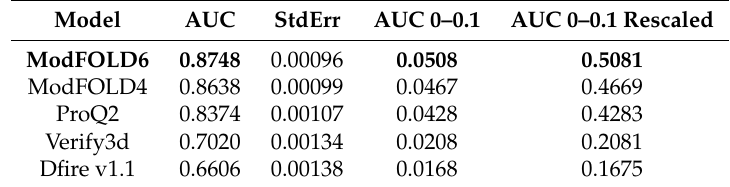
Table A2. Comparison of local scoring performances of EMA methods in CAMEO6